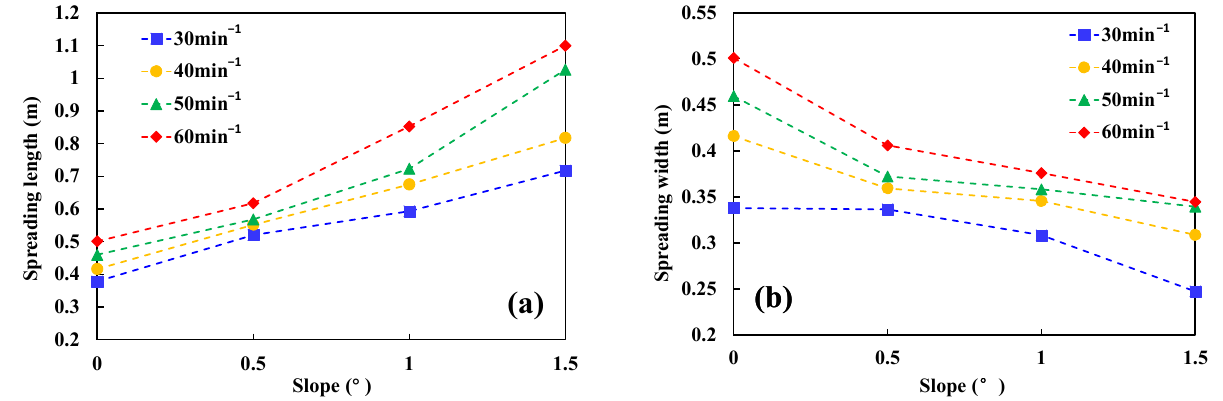
Figure 8. ( a ) The spreading length l on steady stage with different slopes. ( b ) The spreading width d on steady stage with different slopes. Table 4. Variation of burning area with slope in steady stage(m 2 ).